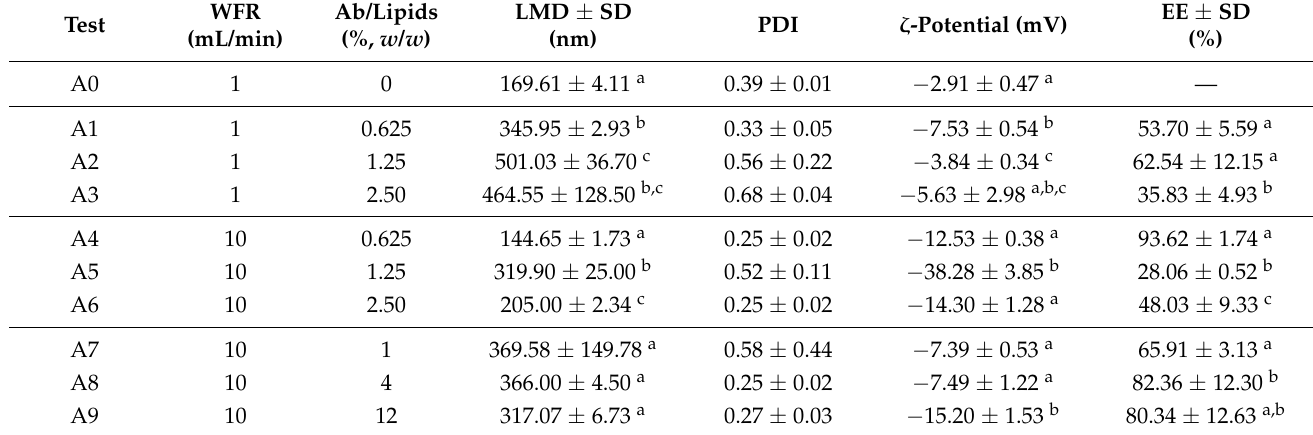
Table 2. SuperLip experimental operative conditions and liposome characterization parameters. Differ- ent letters (a, b, and c) in the LMD, ζ -potential, and EE column refer to statistically significant differences among the different samples of each column ( p < 0.05) by ANOVA with Tukey’s HSD post-hoc multiple comparison test. WFR: water flow rate, Ab/Lipids: antibody-to-lipid mass ratio, LMD: liposome